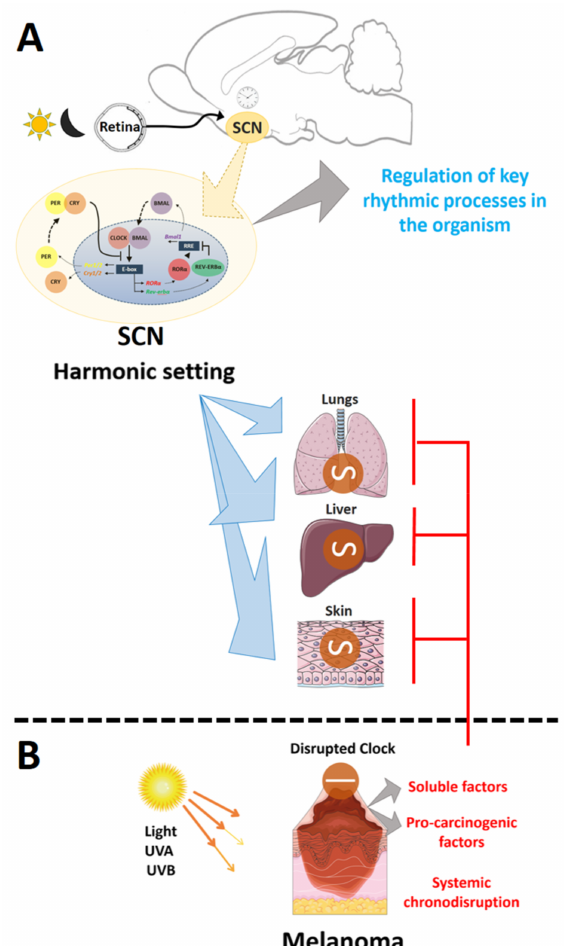
Figure 7. Non-metastatic melanoma leads to systemic chronodisruption in peripheral and central clocks in mice. ( A ) In a physiological situation melanopsin-expressing retinal cells translate the photic information into glutamate release at the suprachiasmatic nucleus (SCN)—the central